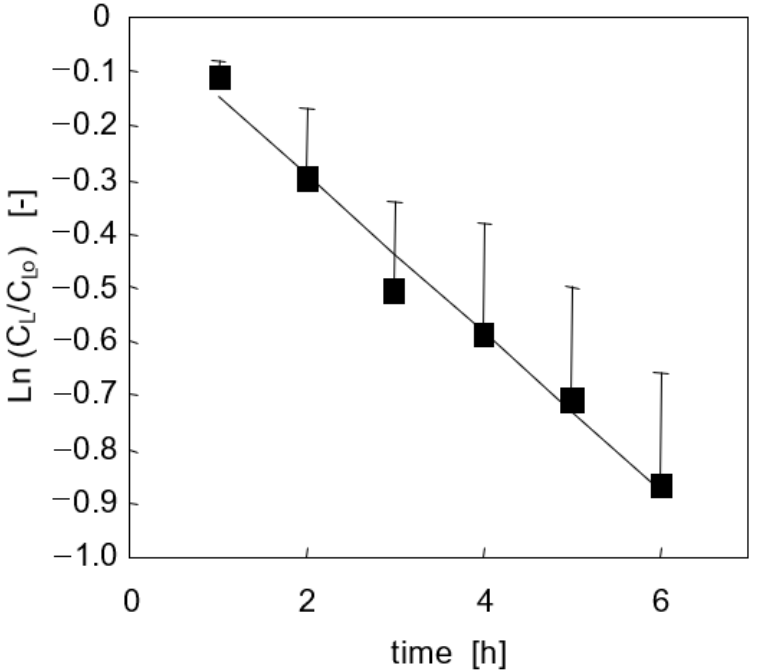
Figure 3. Lidocaine disappearance from medium in adsorption tests with cell-free bioreactors ( n = 7). Line is model prediction.